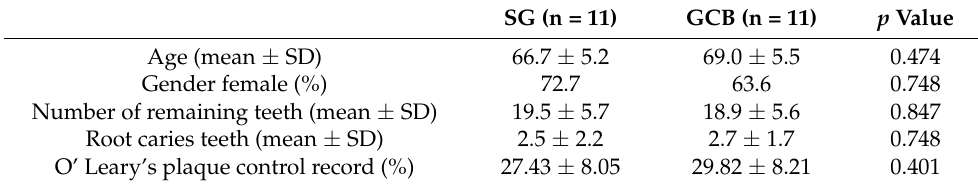
Table 1. Demographic and clinical characteristics of study